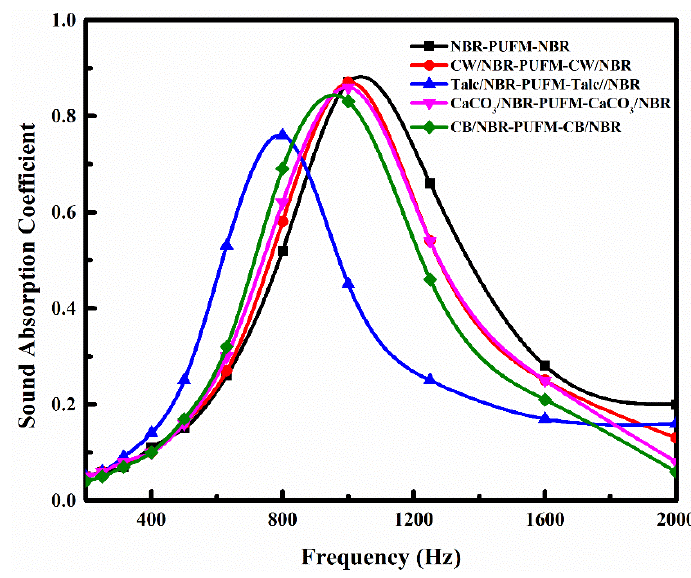
Figure 8. SAC of the sandwich structure NBR-PUFM composites after adding common fillers. Table 3. Maximum and average SAC of the sandwich structure NBR-PUFM composites after adding fillers in the frequency range of 500 to 1600 Hz.